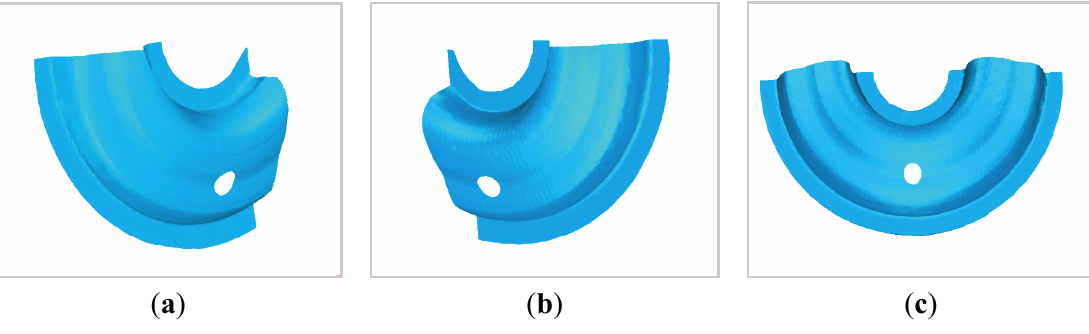
Figure 13. ( a ) 3D morphology of the object measured by the 3D scanning sensor at the first position; ( b ) 3D morphology of the object measured by the 3D scanning sensor at the second position; ( c ) united 3D morphology of the object measured by the 3D scanning sensor at two positions.